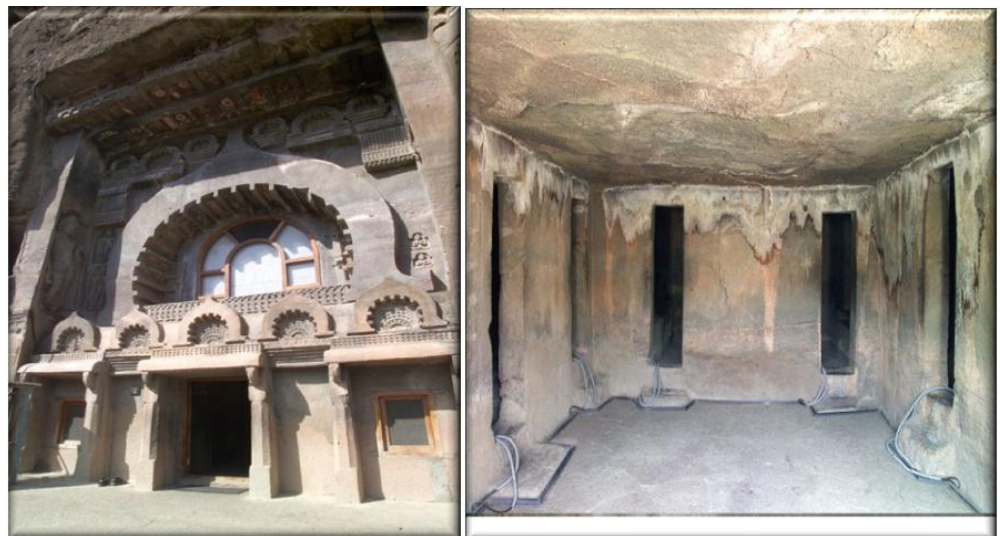
Figure 3. Showing View of Hinayana Caves 9 & inner view of Cave